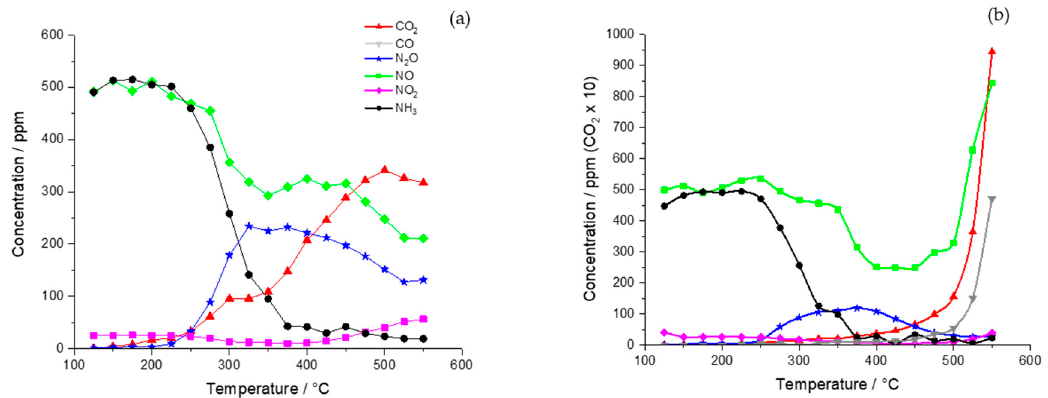
Figure 2. Reaction data for CVI80 catalyst where the simulated exhaust gas consisted of 500 ppm NO, 500 ppm NH 3 , 8% O 2 , and N 2 as the balance gas. The temperature was increased in 25 °C intervals from 125 to 550 °C. (a) catalyst only reaction data, and (b) catalyst and soot data. (Note difference in scales between (a) and (b) for CO 2 concentration.).